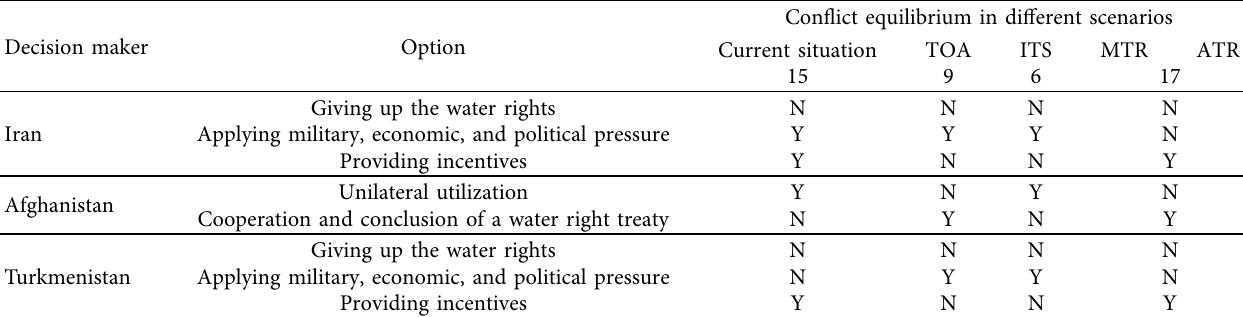
Table 7: Scenarios equilibrium states of the Harirud river conflict in